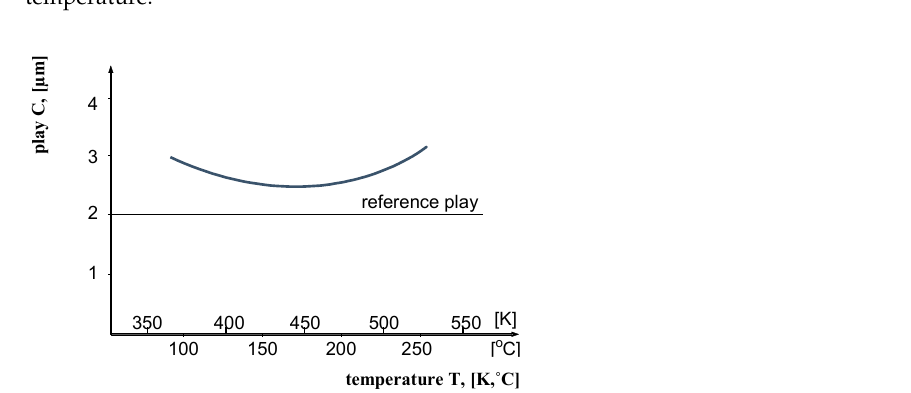
Figure 7. The play in the needle-nozzle holder precision pair of injector 3 as a function of operating temperature.